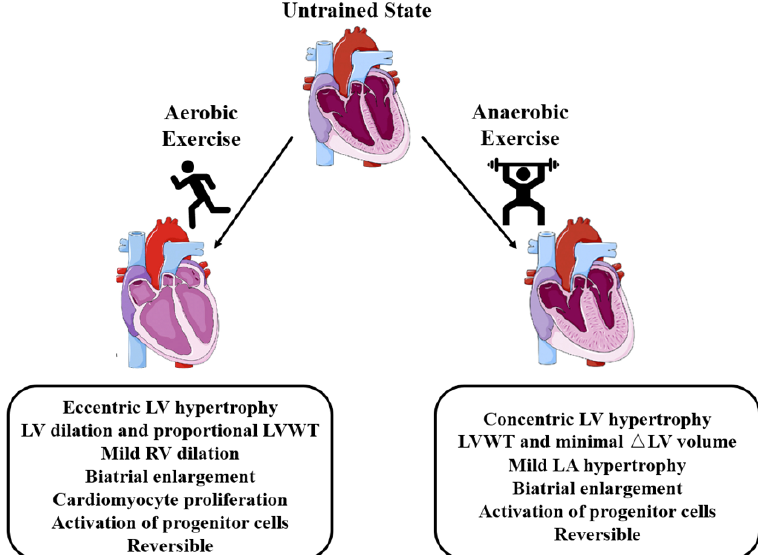
Figure 1. Schematic of exercise-induced cardiac hypertrophy. Aerobic and anaerobic exercise elicits physiological cardiac remodeling. Hypertrophy activation is principally eccentric for aerobic but concentric for anaerobic exercise. LA, left atrium; LV, left ventricle; LVWT, left ventricular wall thickness; RA, right atrium; RV, right